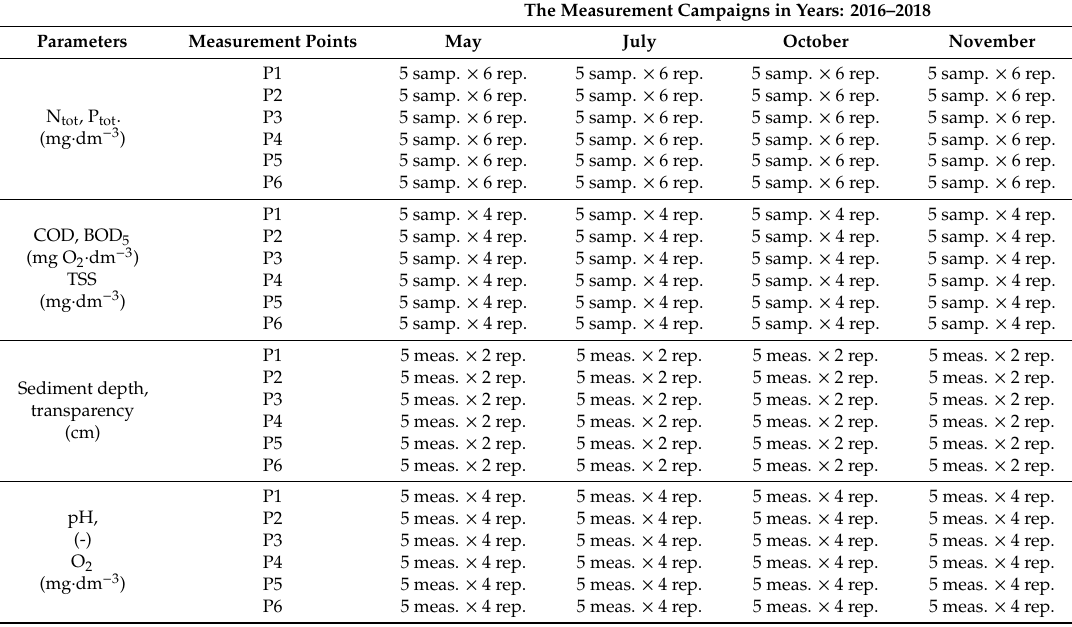
Table2. Thescheduleoflaboratoryindicationandinsitumeasurementduringmeasurementcampaigns. The Measurement Campaigns in Years: 2016–2018